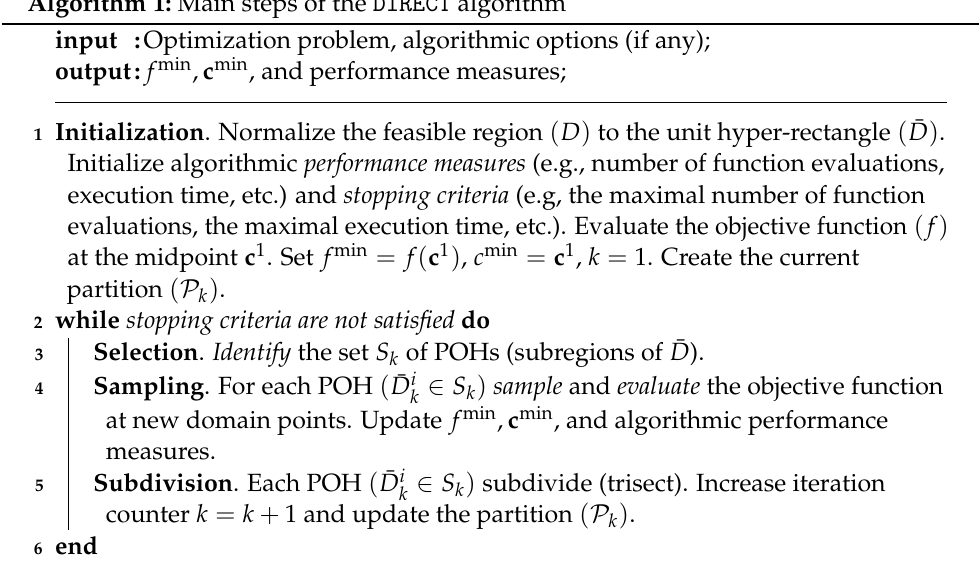
Algorithm 1: Main steps of the DIRECT